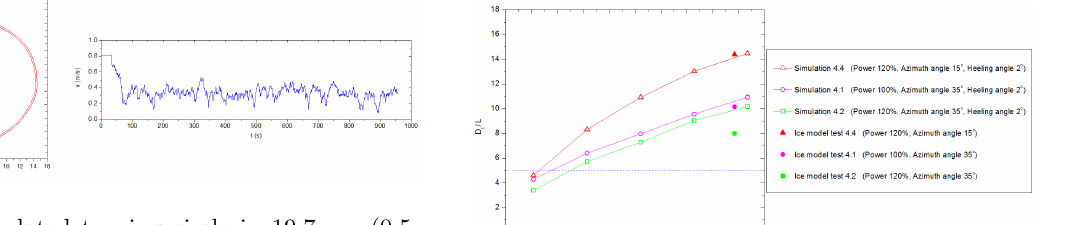
Figure 18: Simulated turning circle in 19 . 7 mm (0 . 5 m full-scale) level ice (power 120%, azimuth angle 35 ◦ ) with the corresponding velocity response. The turning circle is plotted with reference to ship length L .